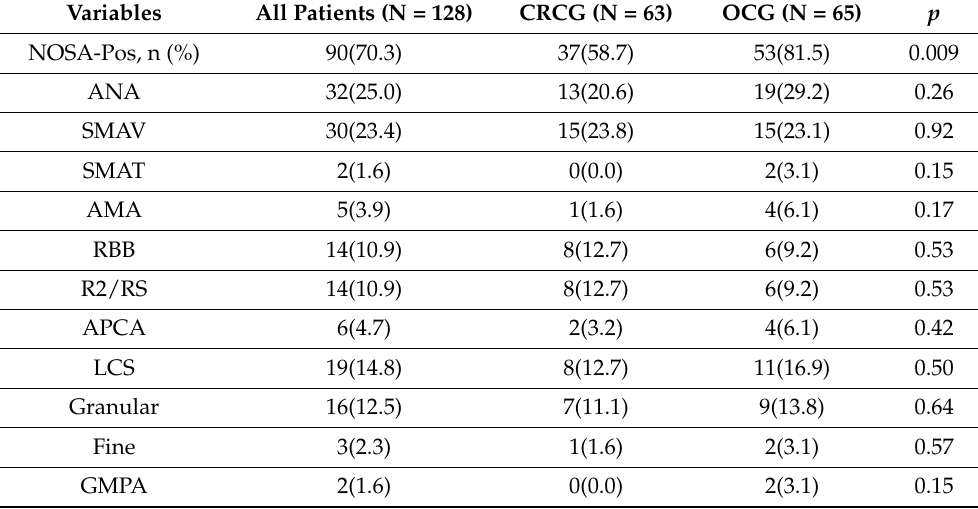
Table 2. Trends in non-organ specific autoantibodies (NOSAs) according to types of reactivity and the two groups of patients (CRCG, colorectal cancer group, and OCG, other cancer group). Abbreviations: AMA, antimitochondrial antibodies; ANA, antinuclear antibodies; APCA, anti-gastric parietal cell antibodies; GMPA, gastric myenteric plexus antibodies; LCS, liver cytosol staining; SMAV, vascular smooth muscle antibodies; SMAT, tubular smooth muscle antibodies; R2/RS, antireticulin R2/RS pattern; RBB, renal brush border